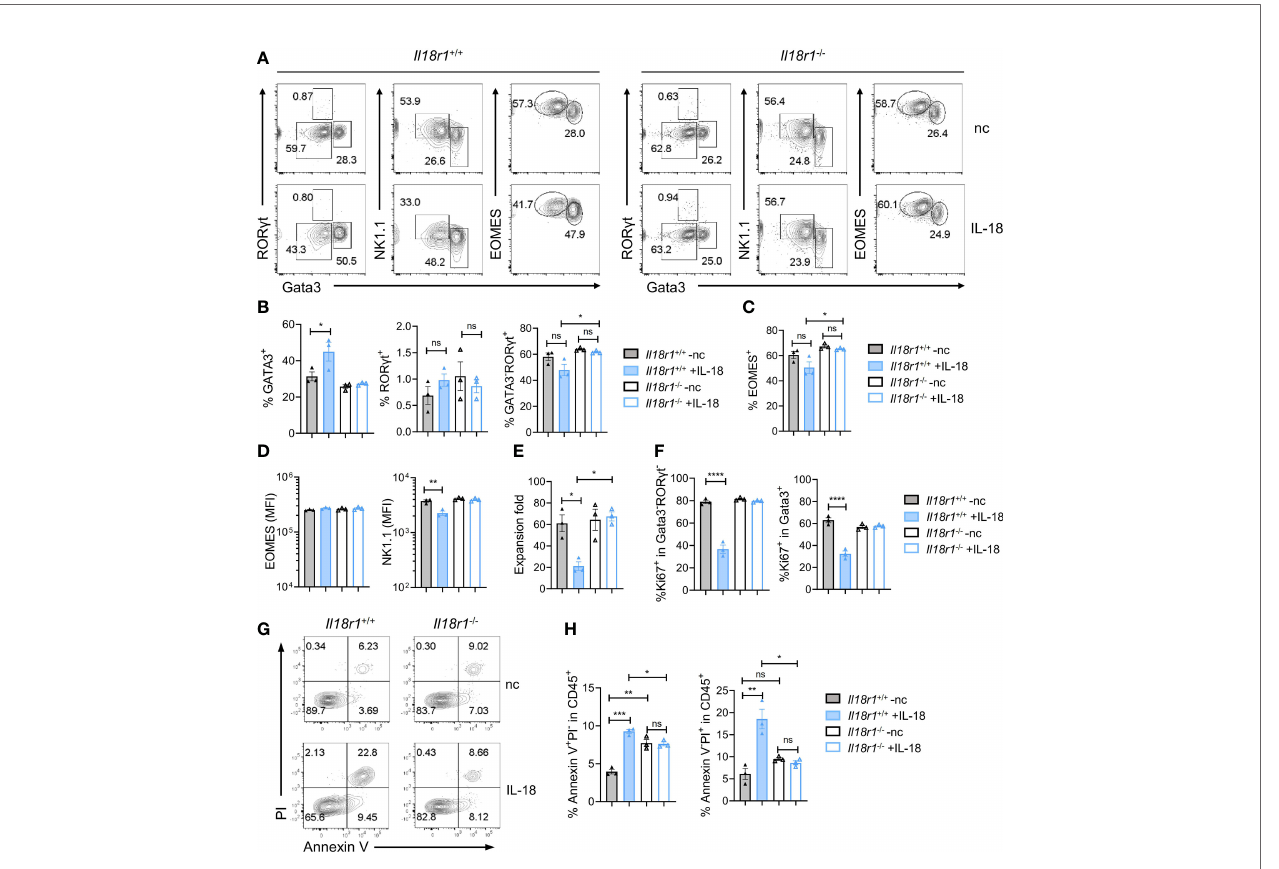
FIGURE 7 | IL-18 suppresses the growth of ILCP/ILCs. Lin - ST2 - PD1 + IL-18R a + cells (350~700 cells) were FACS-sorted from Il18r1 +/+ and Il18r1 -/- BM and cultured on OP9-DL1 in the presence of SCF (20 ng/ml) and IL-7 (20 ng/ml) with or without IL-18 for 7 days. (A) Representative FACS plot showing NK/ILC1, ILC2, and ILC3 generated from the culture. (B, C) Percentage of the NK/ILC1, ILC2, and ILC3 in CD45 + cells from the culture. (D) Mean fl uorescence intensity of EOMES and NK1.1 in GATA3 - ROR g t - cells. (E) Expansion fold of the cultured cells. (F) Percentage of Ki67 + cells in the indicated cell populations. (G – I) Representative FACS plot and statistical analysis showing the percentage of Annexin V + PI - (H) and Annexin V + PI + (I) cells in CD45 + cells from the culture. Data are representative of two independent experiments with three mice in each group. The data were presented as mean ± SEM, analyzed by two-tailed Student ’ s t-test. * p < 0.05; ** p < 0.01; *** p < 0.001; **** p <